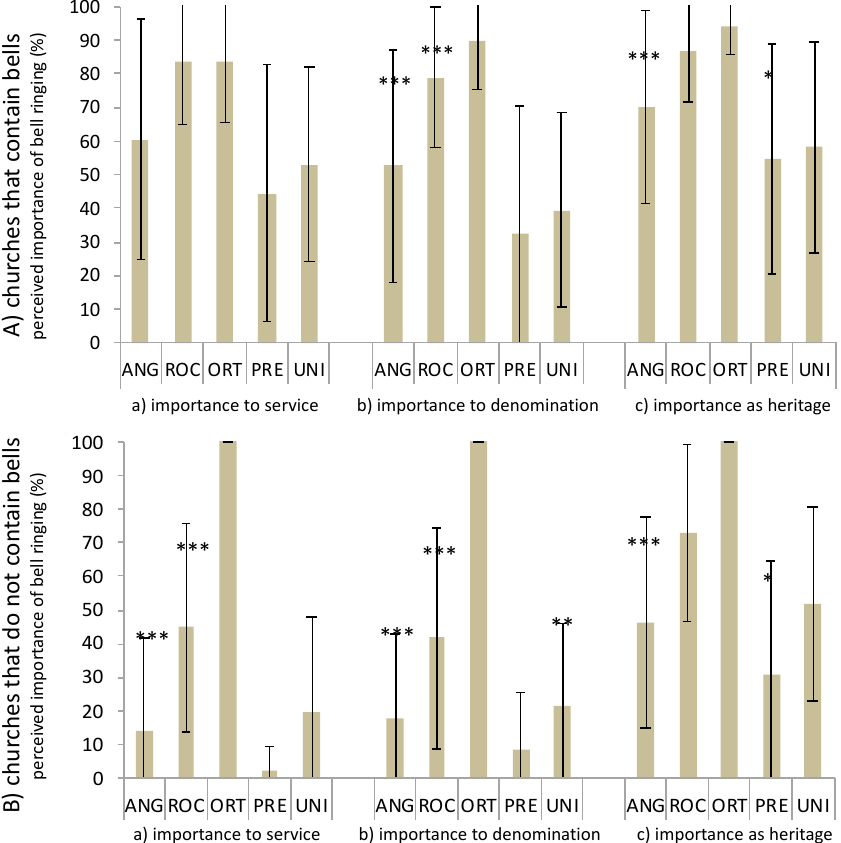
Figure 1. Average perceived importance of bell ringing ( a ) to the services at your church; ( b ) to your denomination overall; and ( c ) as a form of heritage, across all denominations for NSW churches that ( A ) contain any bells and ( B ) do not contain bells. Standard deviation bars included, significant differences within that same denomination denoted by: * for p < 0.05, ** for p < 0.01, *** p < 0.001; for churches with bells vs. churches without bells.